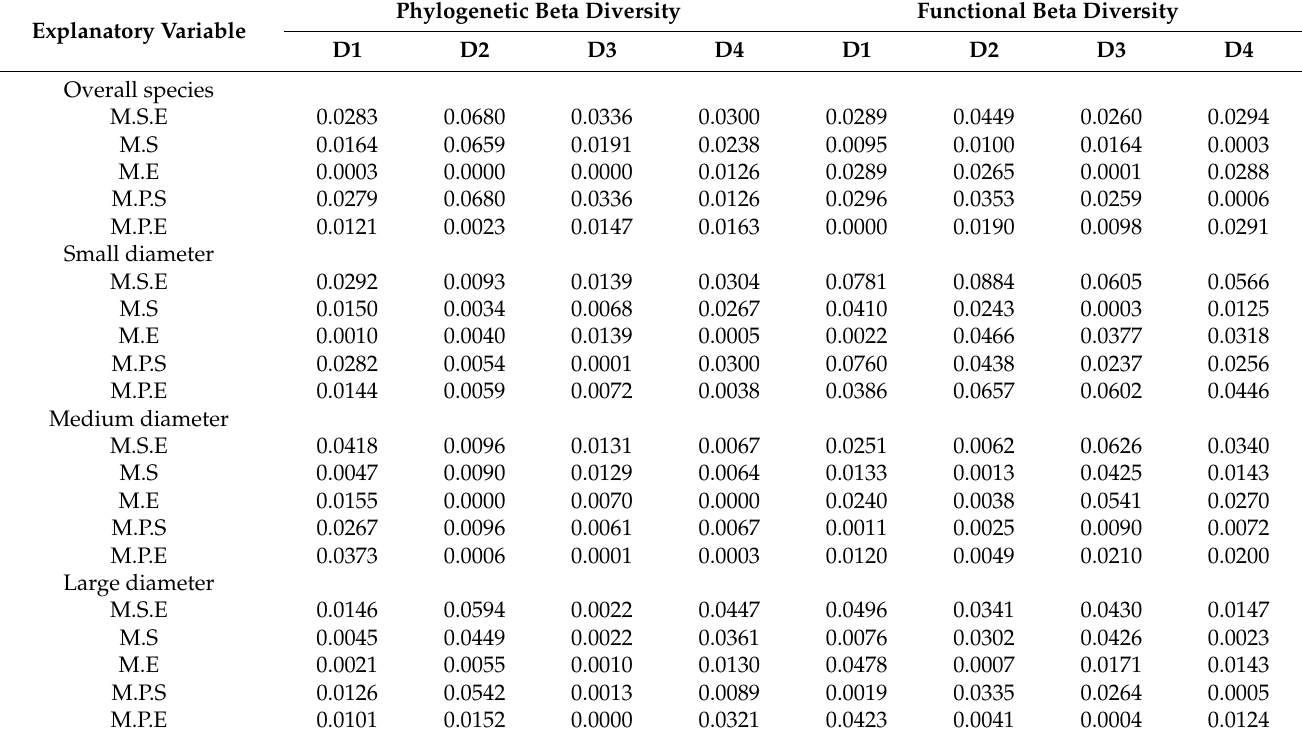
Table 7. Results of multiple regression on distance matrices (MRM) of phylogenetic β -diversity, as predicted by environmental and spatial distance variables in different disturbance communities. D1, D2, D3, and D4 represent plantation, twice-cut, once-cut, and old-growth forests, respectively. M.E.S., multiple regression on distance matrices of environment and space; M.S., multiple regression on distance matrices of space; M.E., multiple regression on distance matrices of environment; M.P.S., multiple regression on distance matrices of pure space; M.P.E., multiple regression on distance matrices of pure